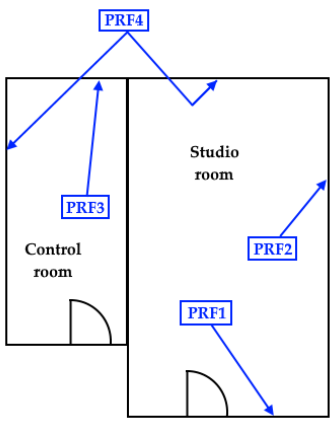
Figure 15. Distribution of the different perforated plasterboards over the rooms.